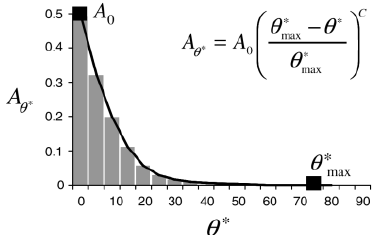
Figure 4. Cumulative distribution of potential contact area ratio A θ ∗ having a minimum inclination θ ∗ [ᵒ] , which is computed with respect to average joint plane and analysis direction (Grasselli,